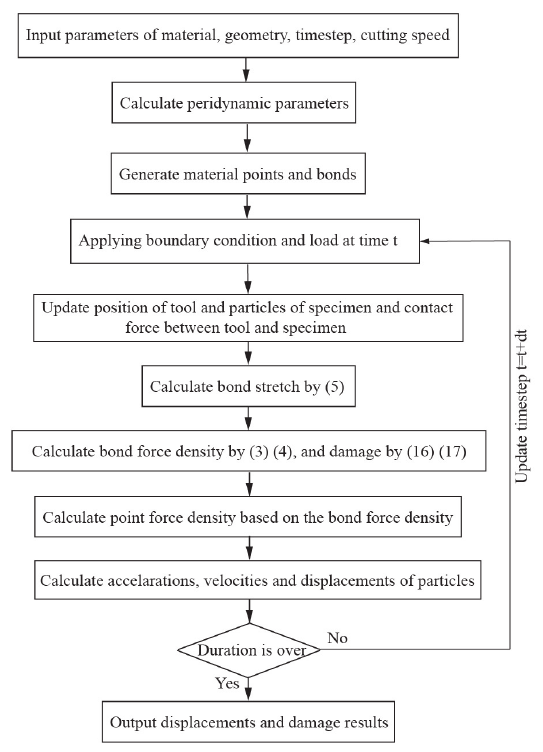
Figure 4. Flow chart for the laminated composites cutting PD